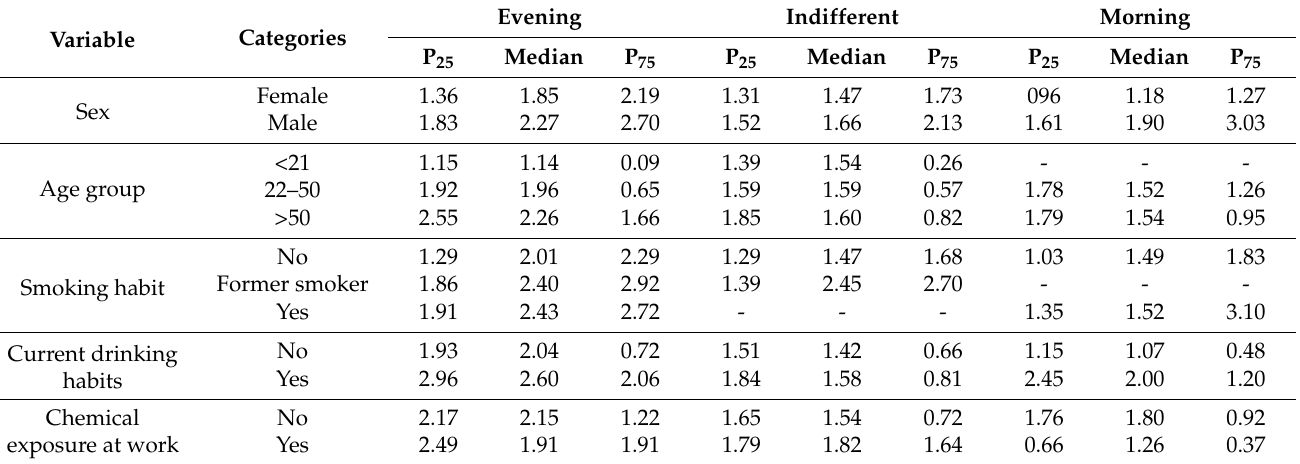
Table 4. Lead in blood ( µ g dL − 1 ) according to PER3 VNTR polymorphism and stratified by age group, drinking habits, and chemical exposure at work.